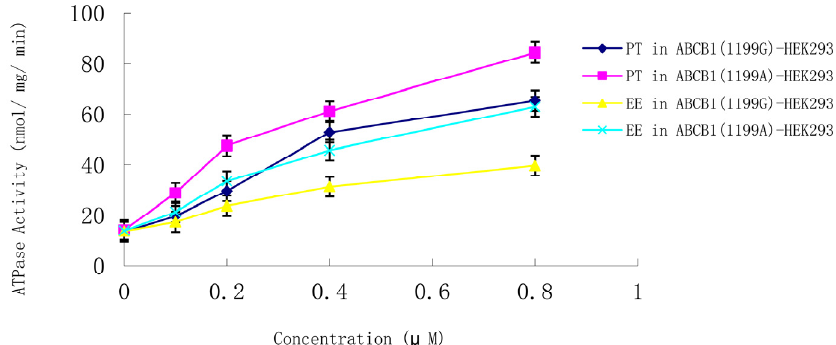
Figure 5. Concentration-dependent stimulation of P-gp ATPase activity by progesterone and ethynyl estradiol (0.1–0.8 μ M) in membranes from LLC-PK1 cells expressing the ABCB1 (1199G) or ABCB1 (1199A) allele. Data shown are mean ± SD of three replicates. EE, ethynyl estradiol; PT, progesterone.